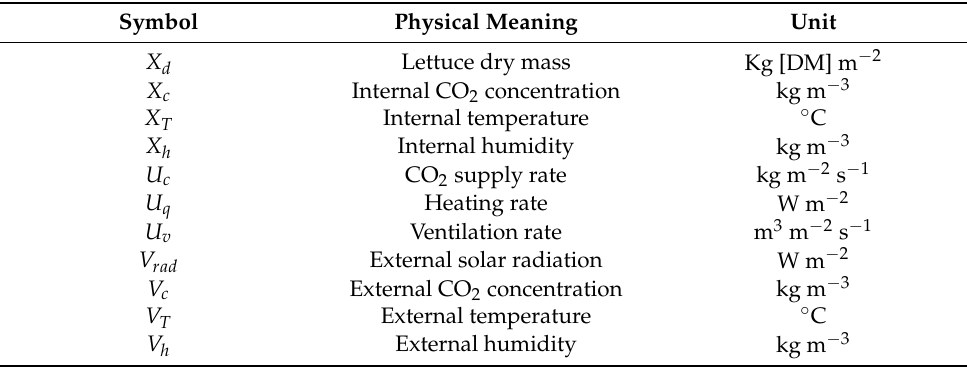
Table 1. Physical meanings and units in the state space mapping.